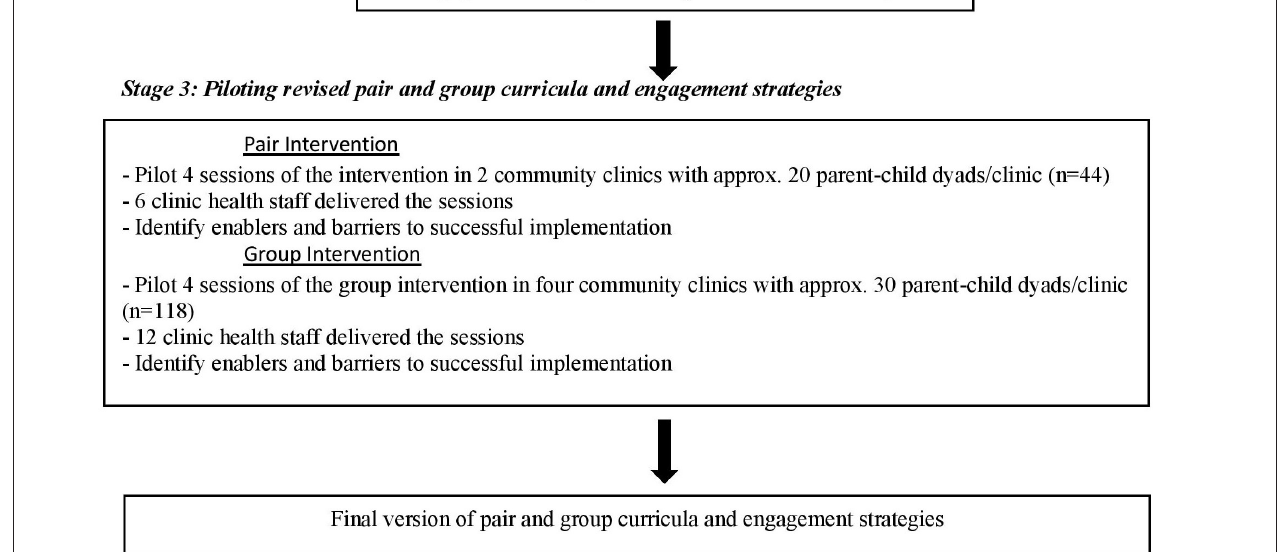
Frontiers in Public Health |